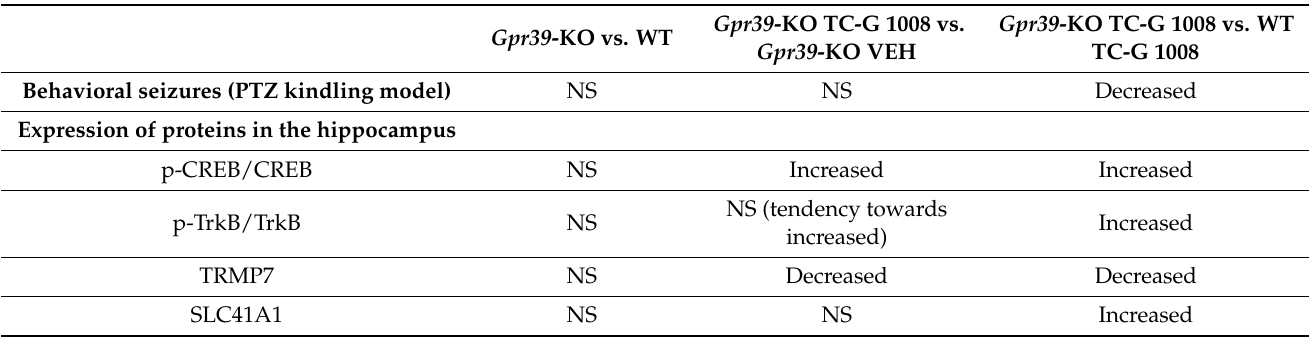
Table 1. Summary of previous and current findings on the effects of TC-G 1008 in the PTZ kindling model in Gpr39 -KO mice. NS—not significant; VEH—vehicle (1% Tween 80 in physiological saline). The Table partly contains data from